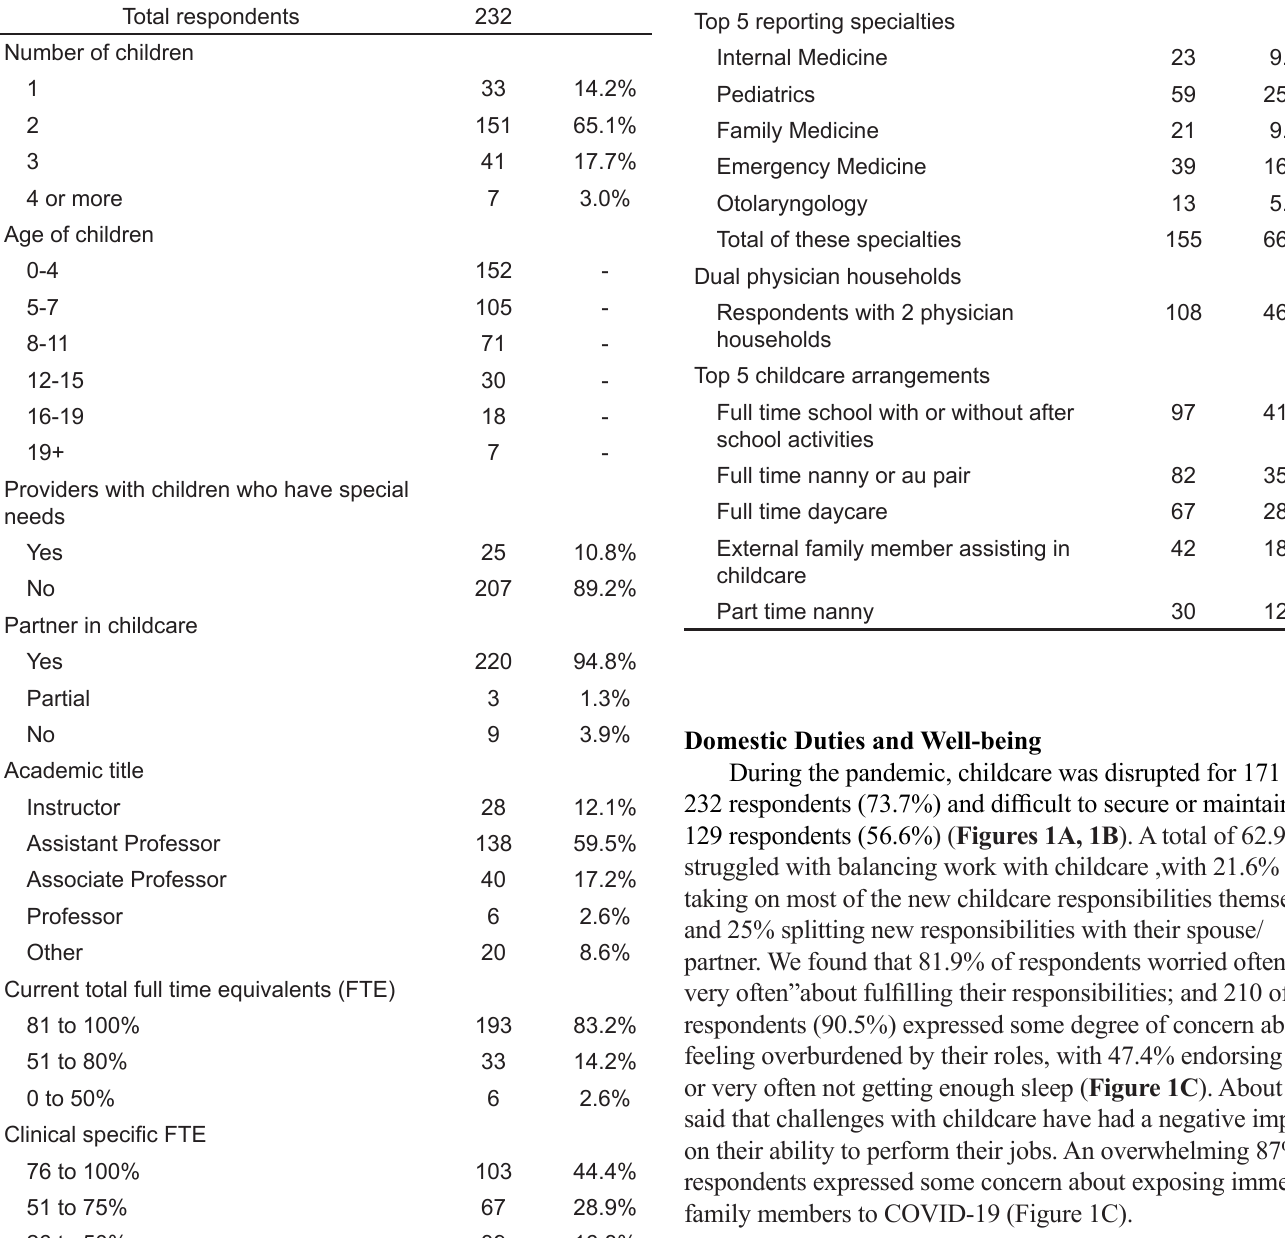
Table 1. Demographic Data of Survey Respondents.